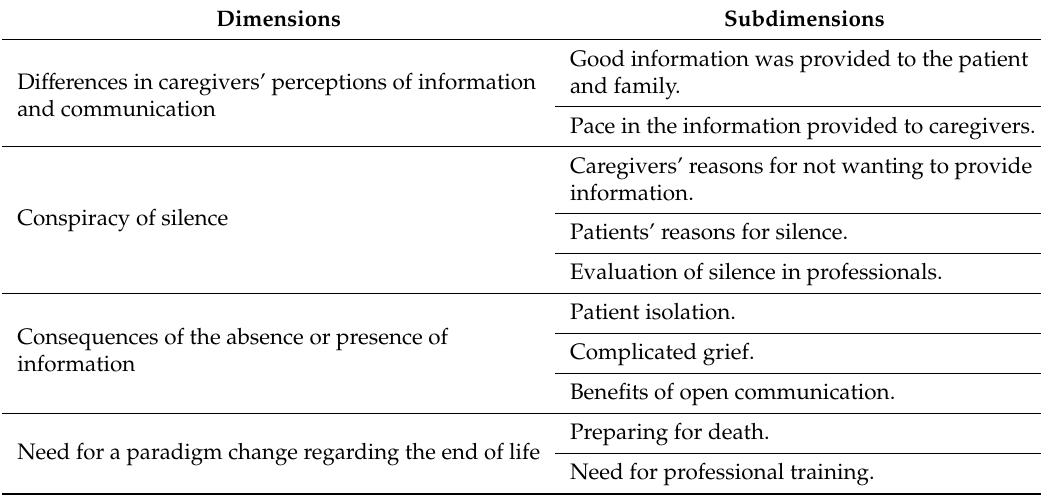
Table 3. Dimensions and subdimensions emerging from the